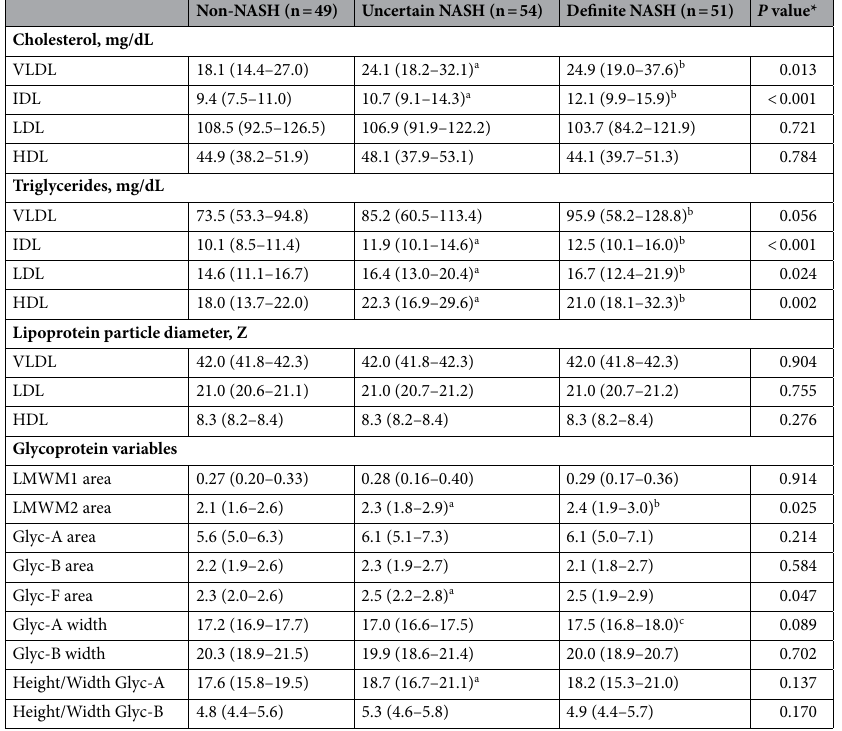
Table 2. Serum cholesterol and triglyceride concentrations in lipoprotein fractions, lipoprotein particle diameter and glycoprotein variables measured by 1 H-NMR segregated with respect to the NAS score. Values are shown as medians and interquartile ranges. HDL high-density lipoproteins; IDL intermediate-density lipoproteins; LMWM low molecular weight molecules; LDL low-density lipoproteins; NAS nonalcoholic fatty liver disease activity score; NASH non-alcoholic steatohepatitis; VLDL very low-density lipoproteins. Superscript letters indicate significant (at least p < 0.05) differences between: a non-NASH vs. uncertain NASH, b non-NASH vs. definite NASH and c uncertain NASH vs. definite NASH. *Global P value using the Kruskal– Wallis one-way analysis of